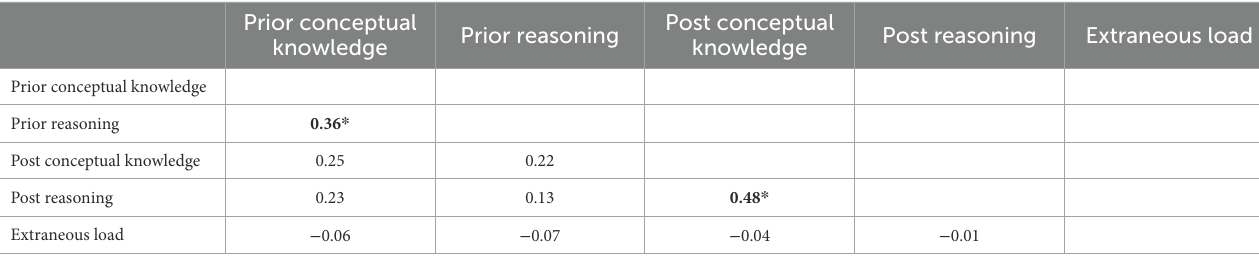
TABLE 4 Intercorrelations of relevant variables in Study